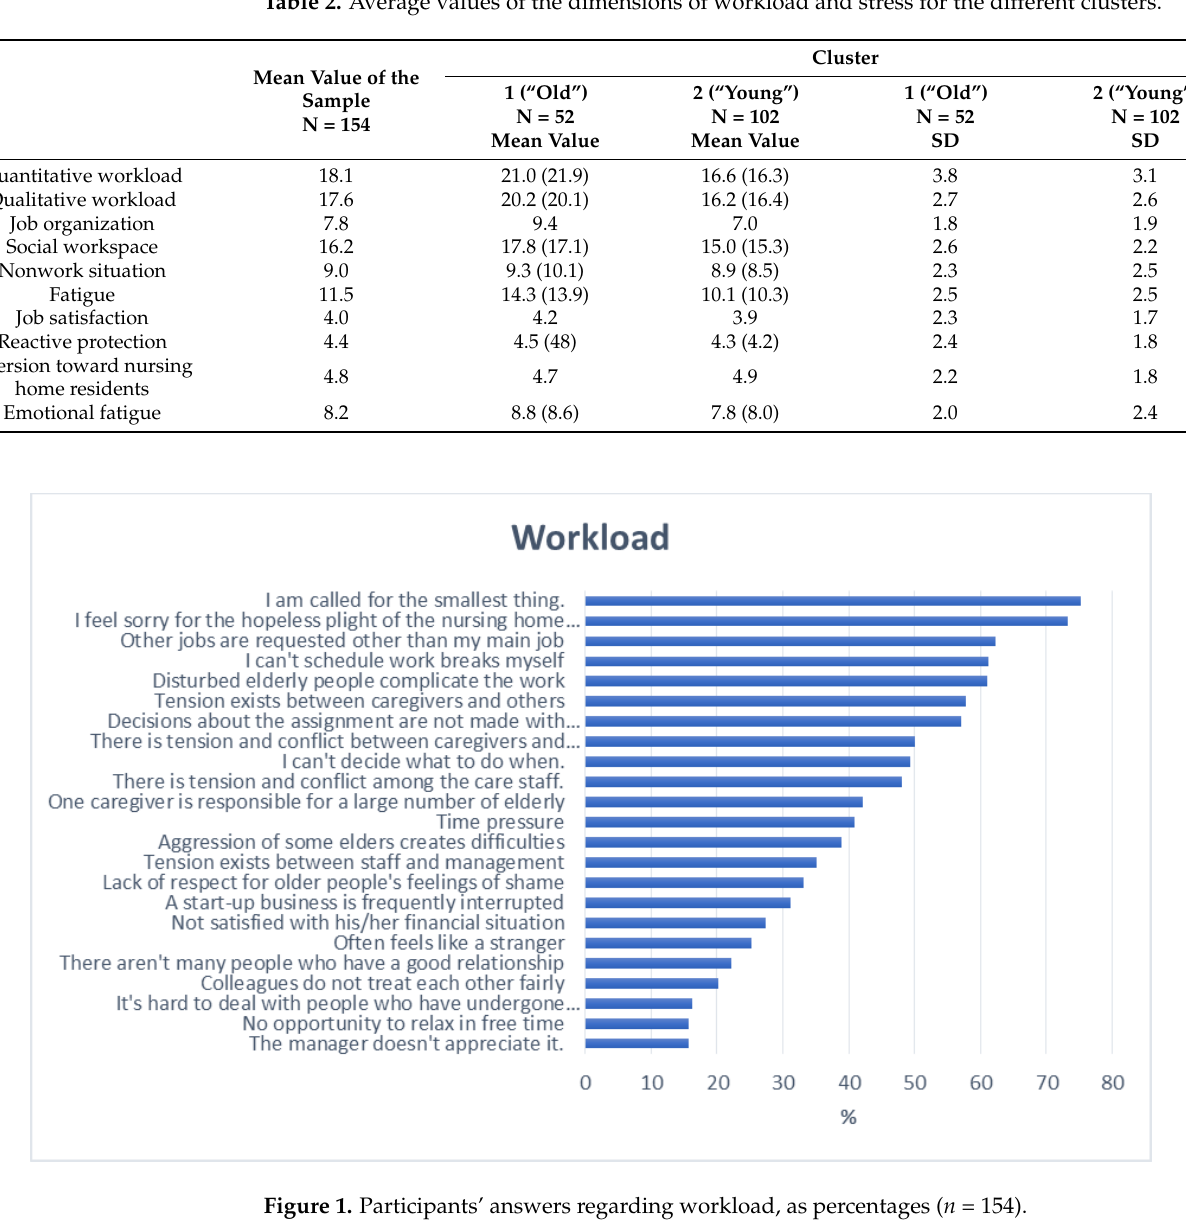
Table 2. Average values of the dimensions of workload and stress for the different clusters.